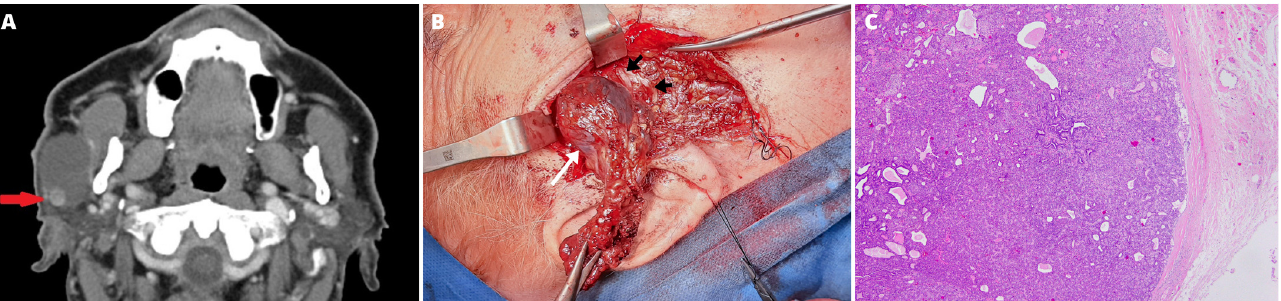
Figure 1. ( A ) Computed tomography (CT) scan at diagnosis showed a unilateral, solitary, well- defined, thin-walled, multilocular cystic lesion located in the superficial lobe of the right parotid gland. In the distal part of the cystic lesion, a contrast-enhancing solid tumor 9 mm in diameter was revealed (red arrow). ( B ) The thin-walled multilocular cyst (white arrow) with the superficial lobe of the parotid gland as a surgical specimen. The cyst was located directly on the lateral aspect of the temporal, zygomatic, and buccal branches of the facial nerve (black arrows). ( C ) The tumor was composed of mixed small cells, partially epithelioid, partially spindle without marked cytological atypia, with a tendency to form trabecular structures. HE, obj. magnification 200×.